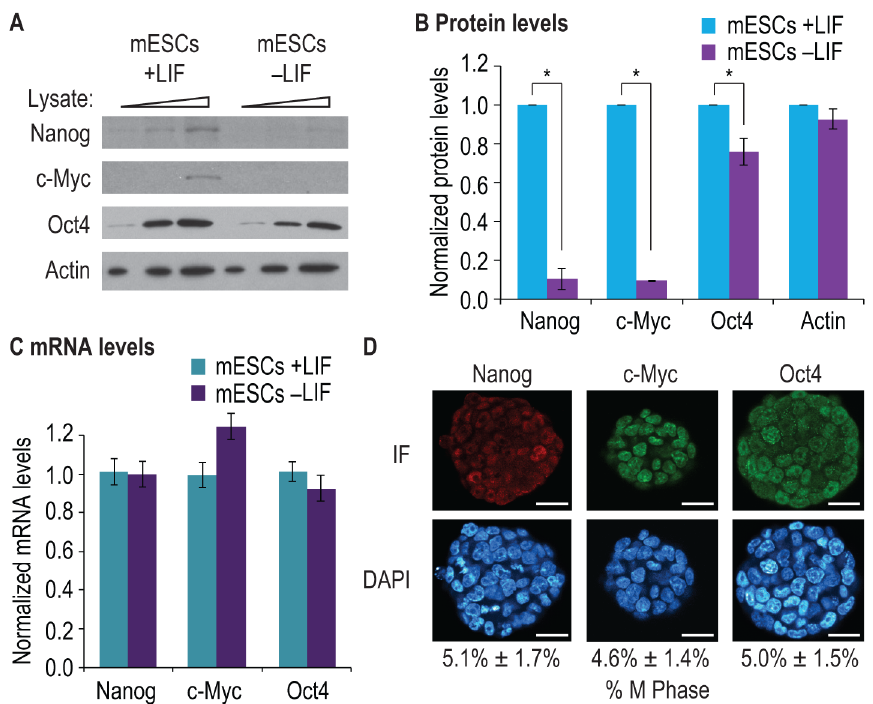
Fig 3. eIF2 α phosphorylation correlates with Nanog and c-Myc expression. (A) mESCs were cultured for 24 h either with LIF (mESCs +LIF) or without LIF (mESCs – LIF). Increasing amounts of cell lysate (indicated by triangles) were separated by SDS-PAGE and western blotted for indicated proteins. Nanog and c-Myc protein levels decreased after LIF withdrawal, whereas Oct4 levels were more modestly decreased when LIF was withdrawn. Actin served as a loading control. (B) Three biological replicates were prepared as in (A) and quantitated. Data were then normalized to values from mESCs grown with LIF. Error bars represent s.d. ( * , p < 0.01 compared to mESCs +LIF samples). (C) RNA was prepared from mouse ESCs cultured as in (A) and RT-qPCR used to assay abundance of indicated RNAs. Loading was normalized to